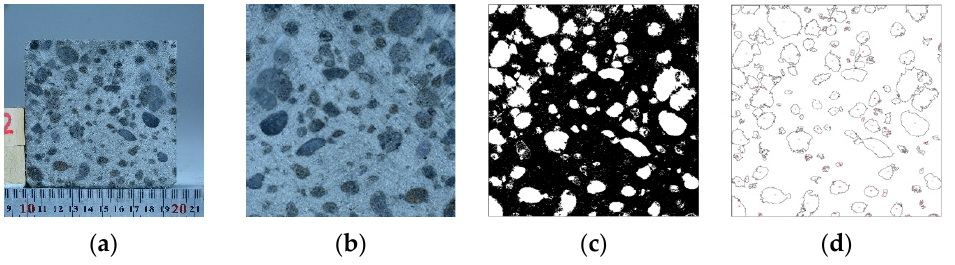
Figure 3. Image analysis process: ( a ) original photo; ( b ) cropped photo; ( c ) after binarization; ( d ) outlines of ceramsite beads.